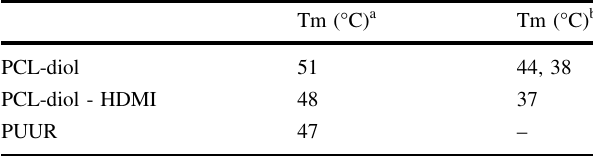
Table 3 Summary of thermal behavior of polymer